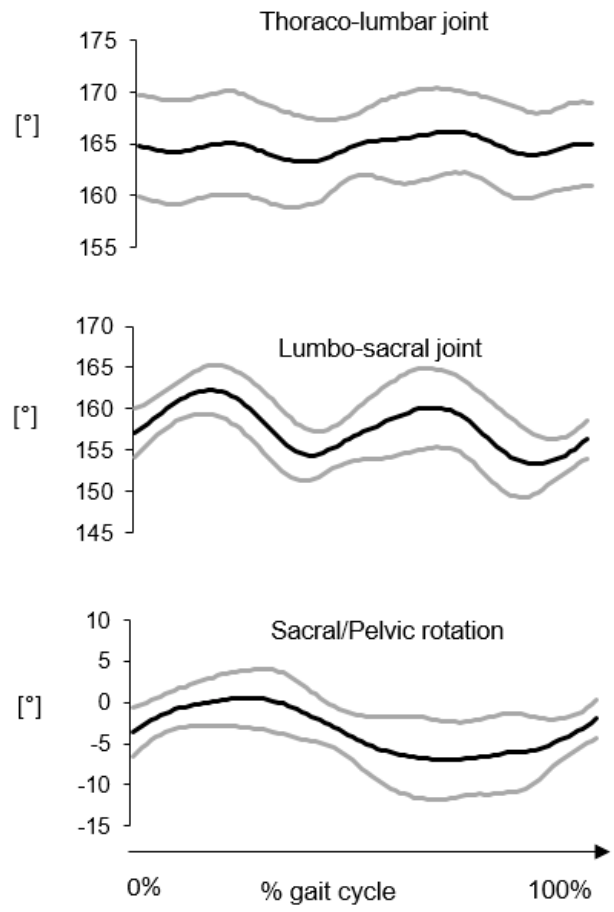
Figure 5. Thoraco-lumbar and lumbar-sacral joint kinematics in the horizontal plane. The average curve (black line) ± the standard deviation (grey lines) were computed over six gait cycles for each subject then averaged for 8 subjects.